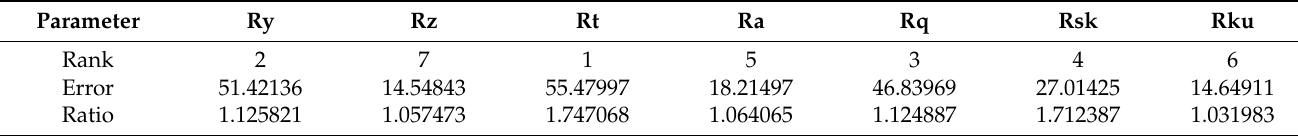
Table 10. Results of the sensitivity analysis for the network 7:7–9-1:1